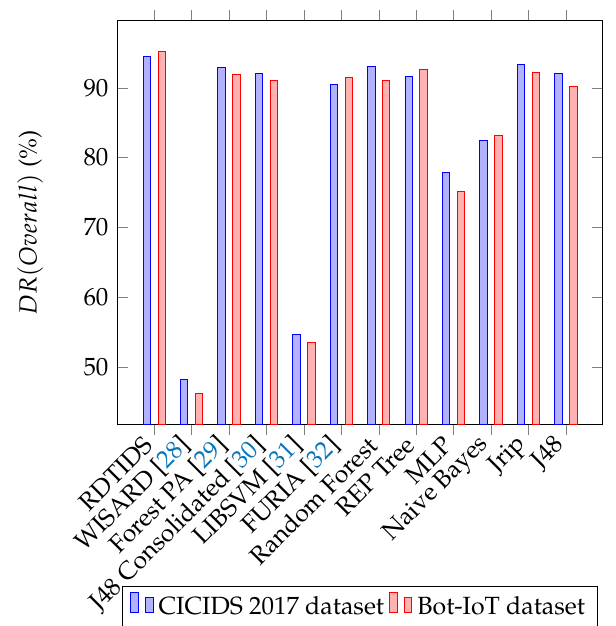
Figure 4. Overall Performance of RDTIDS and other classifiers in terms of global detection